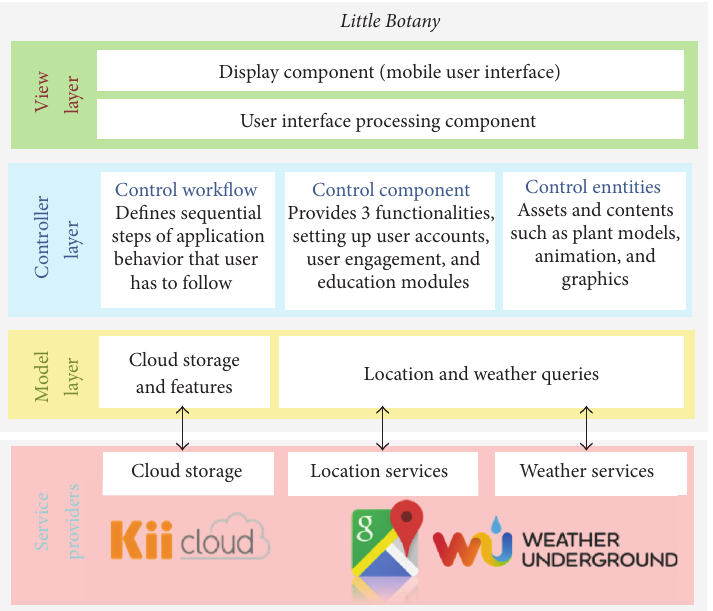
Figure 5: The system architecture of Little